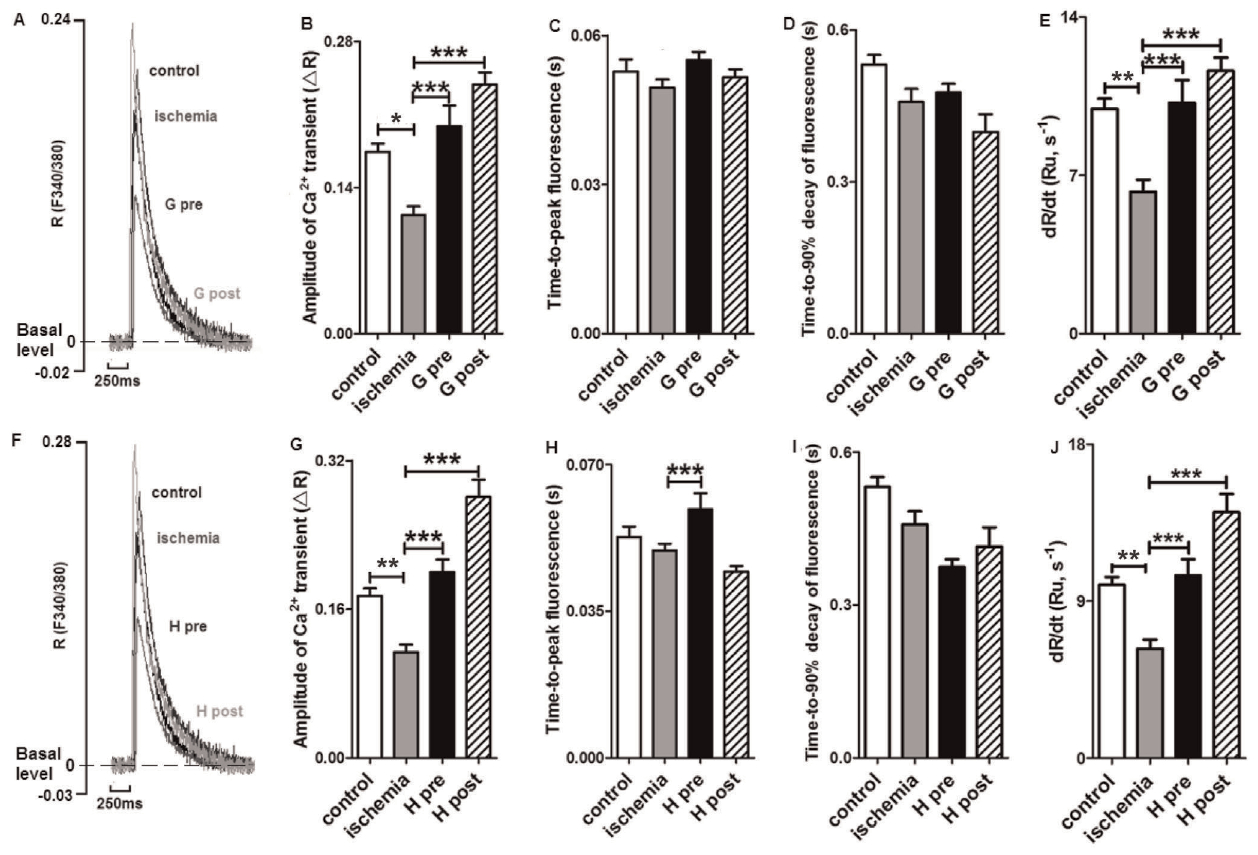
Figure 3. Effects of GHS on [Ca 2 + ] i transients in cardiomyocytes exposed to ischemia?reperfusion. (A) and (F) are representative superimposed traces of [Ca 2 + ] i transient after ghrelin (G) or hexarelin (H) pre-treatment (pre) and post-treatments (post). R represents the emission fluorescence ratio of fura-2 from excitation at 340 and 380nm, and Ru represents the ratio unit. Both hexarelin and ghrelin improved the reduced amplitude of [Ca 2 + ] i transients (B and G). The time-to-peak fluorescence was prolonged in ghrelin and hexarelin pre-treatment (C and H) groups, but the decreased rate of rise of [Ca 2 + ] i transients after ischemia was reversed to control level by all H and G pre- and post-treatments (E and J). Ghrelin and hexarelin had no effect on the time-to-90% decay of [Ca 2 + ] i transient (D and I). n = 72, 80, 90, 103, 63 and 66 cells/3 mice in control, ischemia, G pre, G post, H pre and H post groups, respectively. Data are shown as means 6 S.E.M. and analyzed by One-way ANOVA with Tukey’s post hoc test. * P , 0.05, ** P , 0.01, *** P , 0.001 vs ischemic